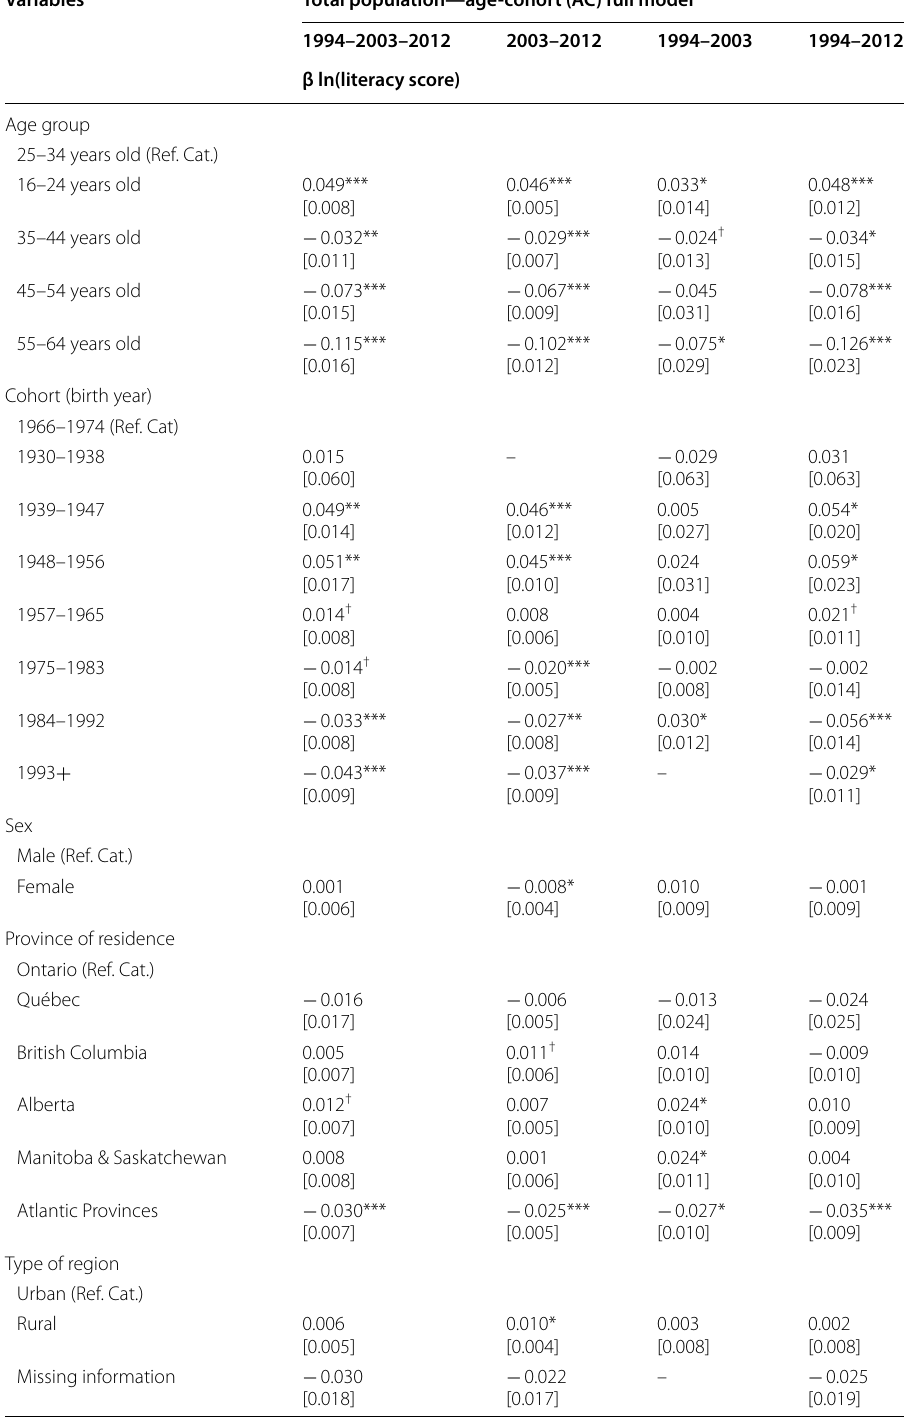
Table 5 Weighted linear regression of the natural logarithm of the literacy score, Canada, 1994 IALS, 2003 ALL and 2012 PIAAC data combined (full model—with all control